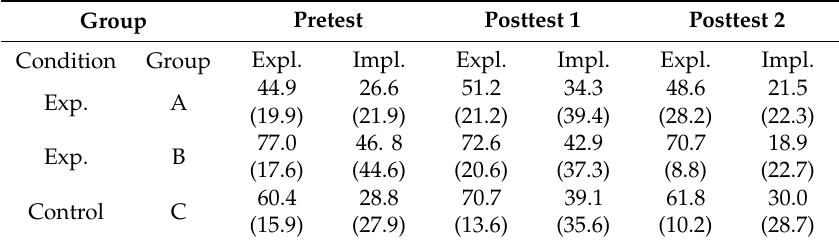
Table 3. Means (and standard deviations) for question types (in